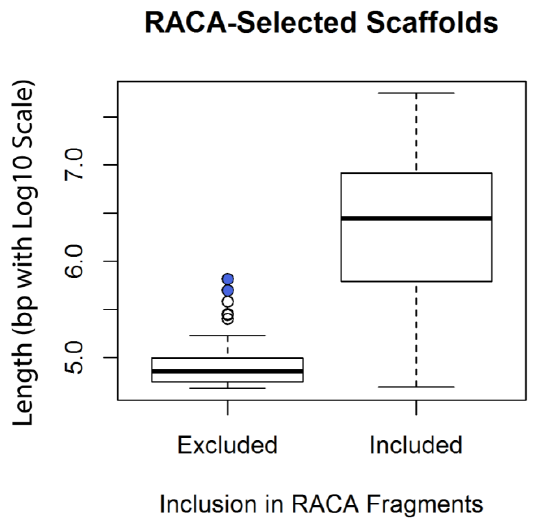
Figure 1. Box plot indicating lengths of scaffolds included and excluded from Reference-Assisted Chromosome Assembly’s (RACA’s) assembled fragments. RACA was provided with the largest 500 scaffolds, which ranged from 48 to 55,683 Kbp. The scaffolds included in the assembly spanned approximately the full range of sizes (50 to 55,683 Kbp) whereas the excluded scaffolds tended to be smaller (48 to 656 Kbp). The outlier points shaded in blue represent scaffolds 292 and 310, which were experimentally demonstrated to contain red fox Y-chromosome sequence [14], and therefore would not be expected to be included in RACA’s assembled fragments.